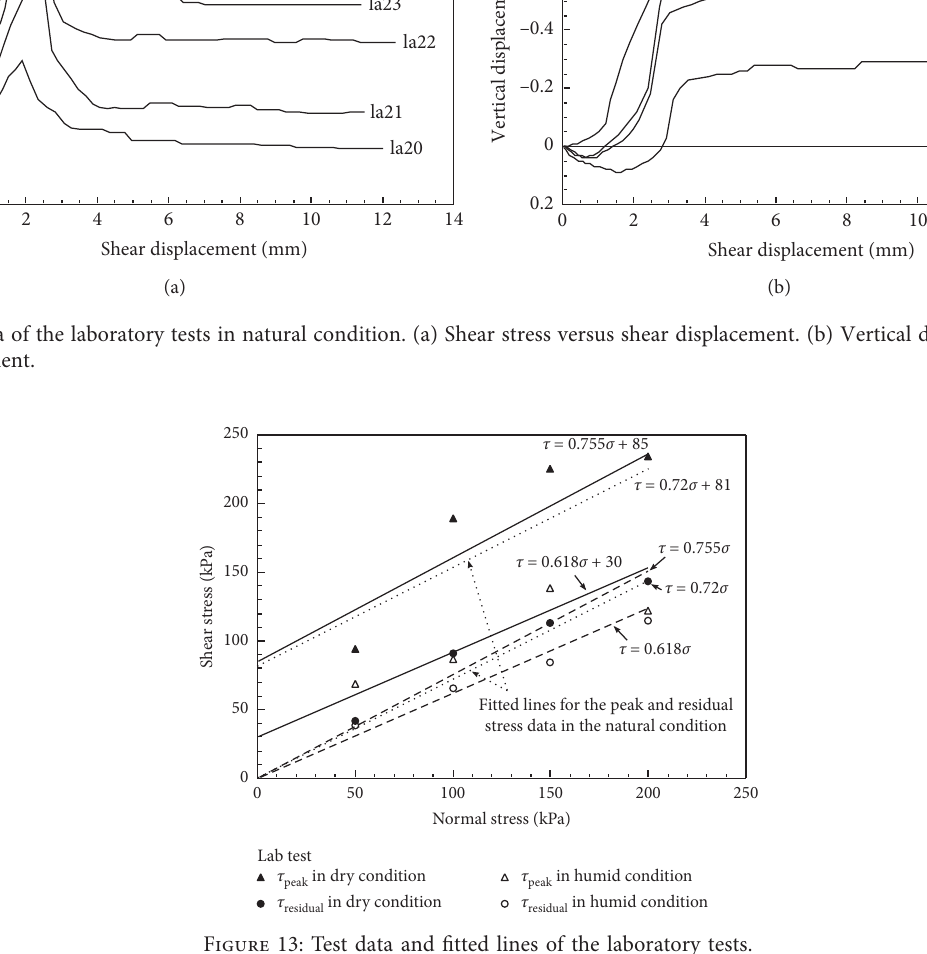
Figure 13: Test data and fitted lines of the laboratory tests. Table 4: Strength parameters obtained from the laboratory tests. Humidity condition Cohesion, c (kPa) Frictional angle, φ ( ° ) Dry 85